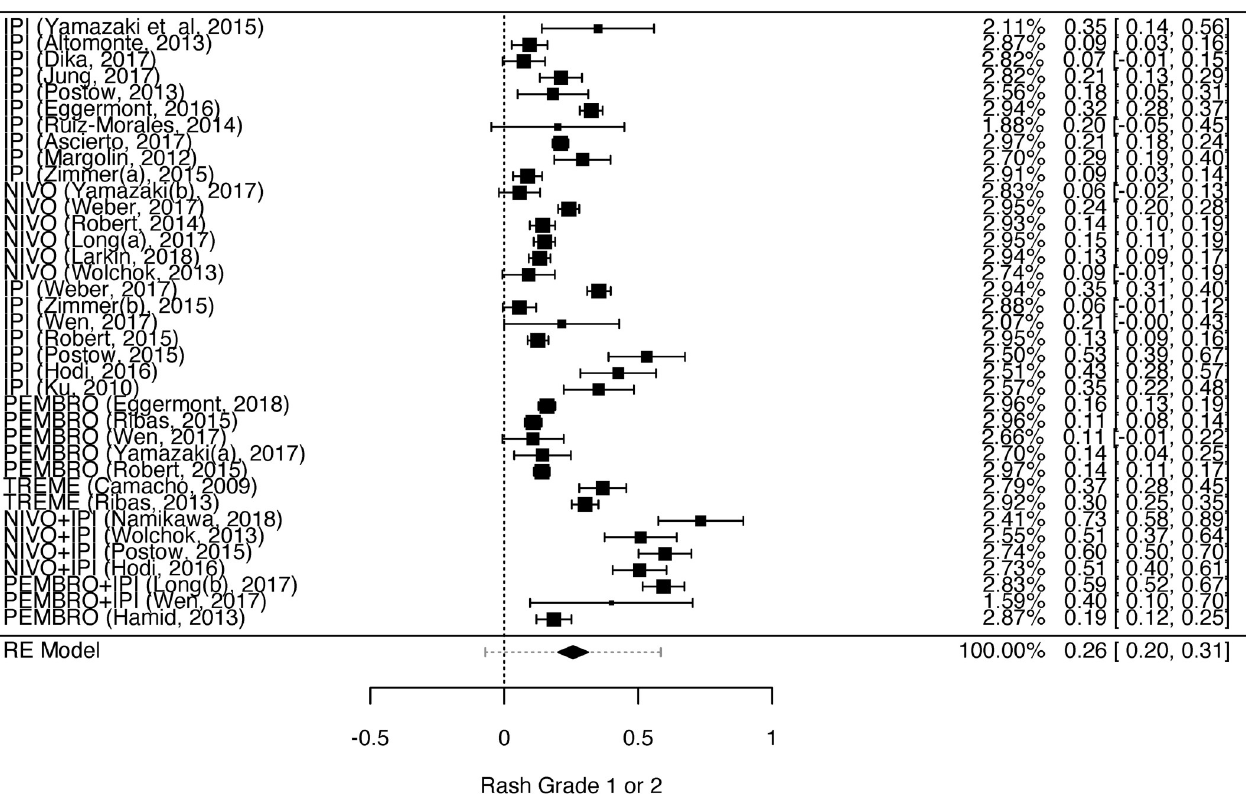
Fig 2. Meta-analysis of rash outcome grade 1 or 2. Elaborated by the authors using JAMOVI 1 . Legend: IPI—Ipilimumab, NIVO—Nivolumab, PEMBRO— Pembrolizumab, TREME—Tremelimumab.